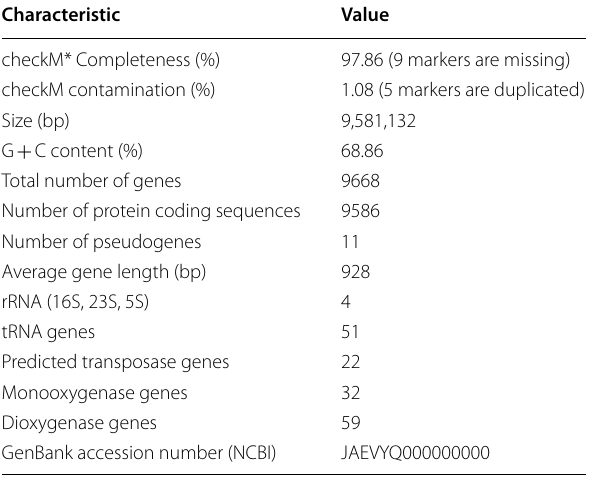
Table 1 General features of the genome Variovorax paradoxus strain